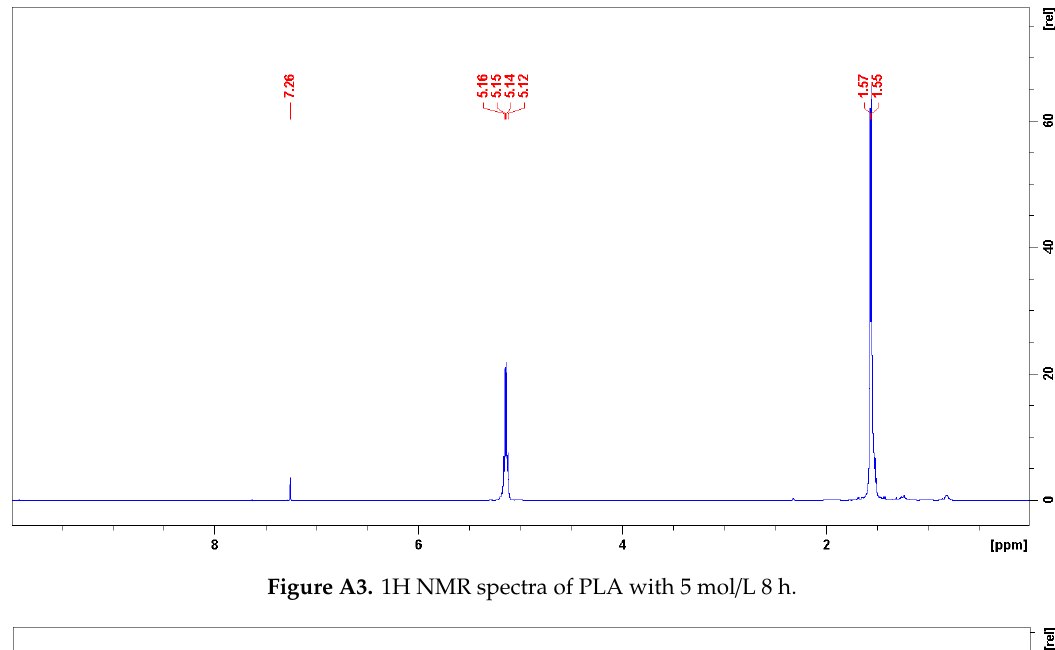
Figure A3. 1H NMR spectra of PLA with 5 mol/L 8h.